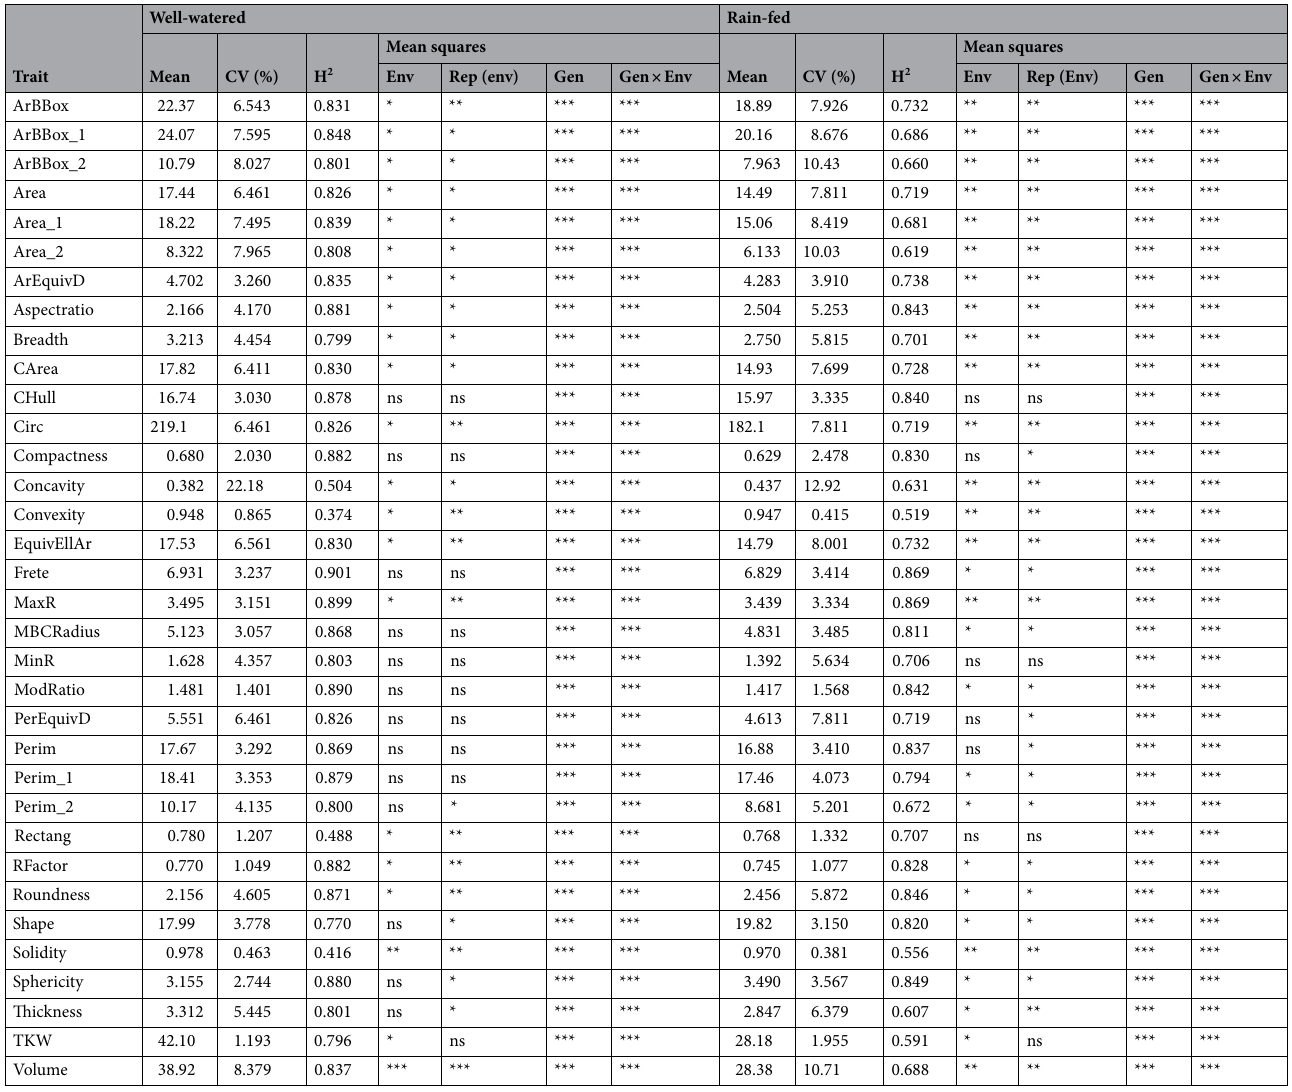
Table 1. Mean, coefficient of variation (CV), broad sense heritability (H 2 ), and combined analysis of variance based on studied traits in 298 Iranian wheat landraces and cultivars. *, **, *** and ns are significant at the probability levels of 5%, 1%, 0.1%, and non-significant,